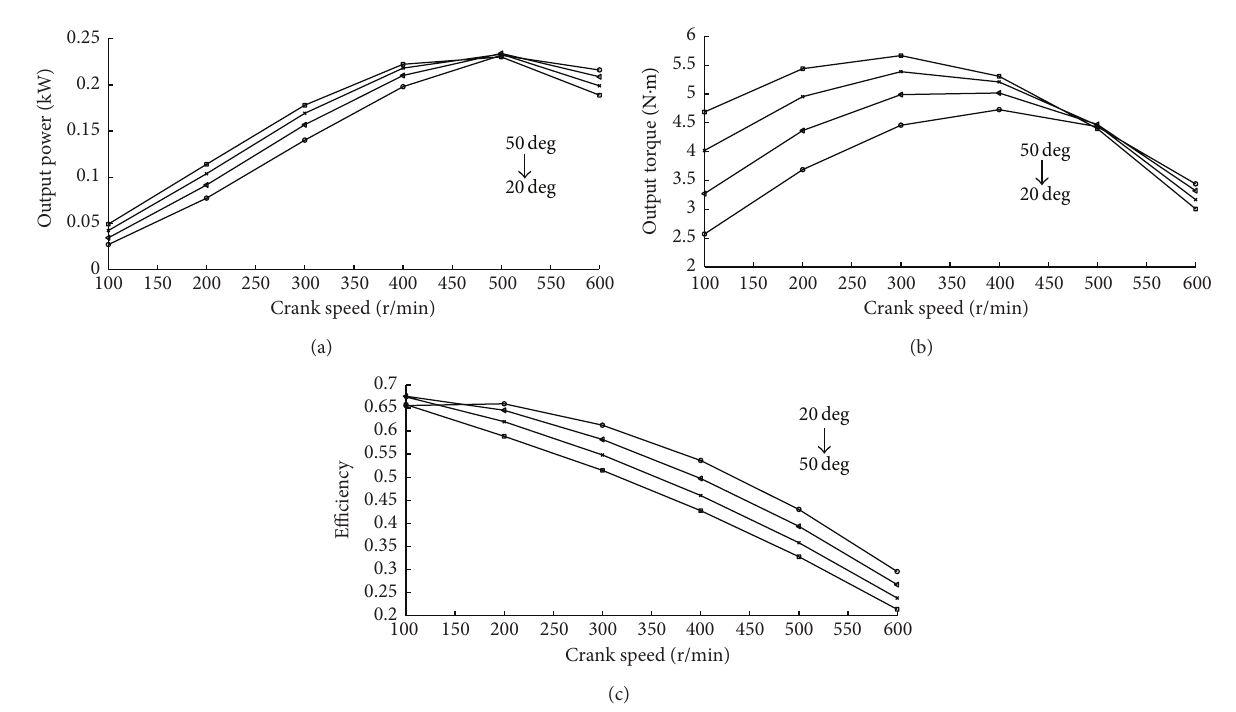
Figure 9: The relationship of IVD and performance of